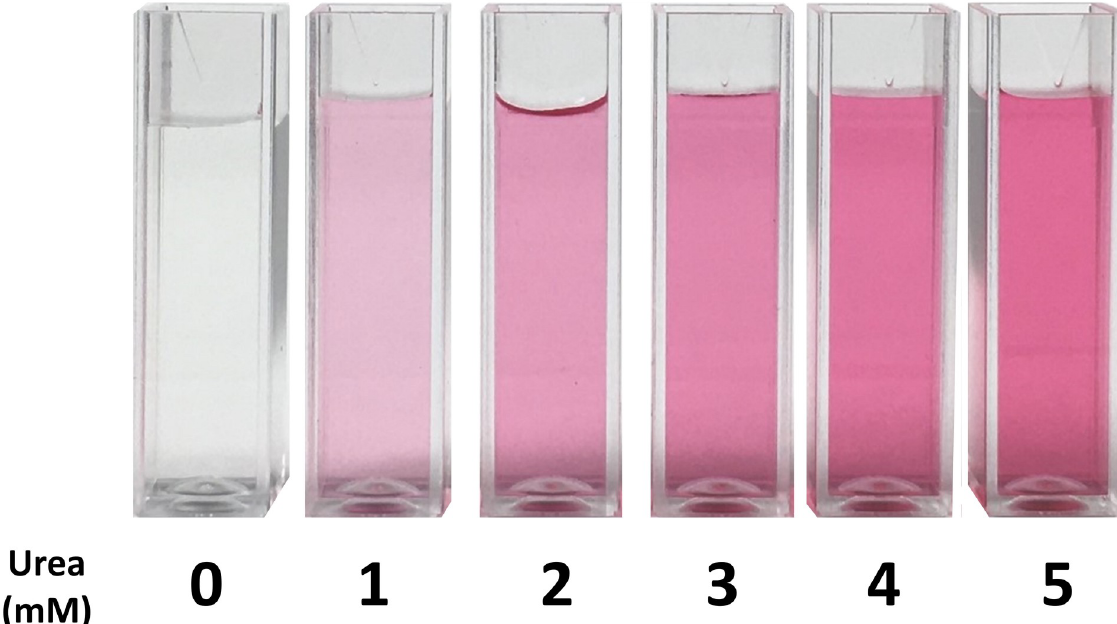
Fig 1. Urea samples after absorbance measurement. Diacetyl monoxime and urea produce a pink-colored complex in the presence of ferric ions with a maximum absorbance at 520 nm proportional to urea concentration.